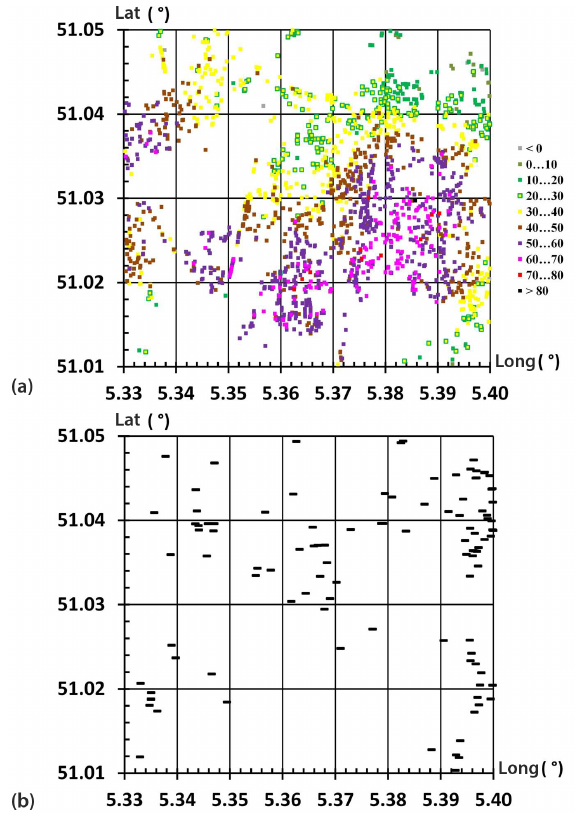
Figure 6. Spatial variation of total surface movement in the area be- tween a latitude of 51.01 and 51.05 ◦ N, and a longitude of 5.33 and 5.40 ◦ E: (a) period 2, 5-year time zone, from mid-September 2005 through mid-September 2010 (all reflectors; color scale is in mm); (b) period 2, 2.5-year time zone, from December 2003 through June 2006 (only reflectors with a downward movement during this time